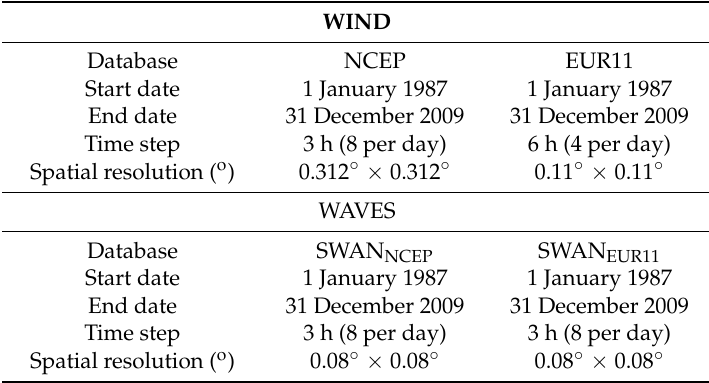
Table 2. Characteristics of the datasets considered for